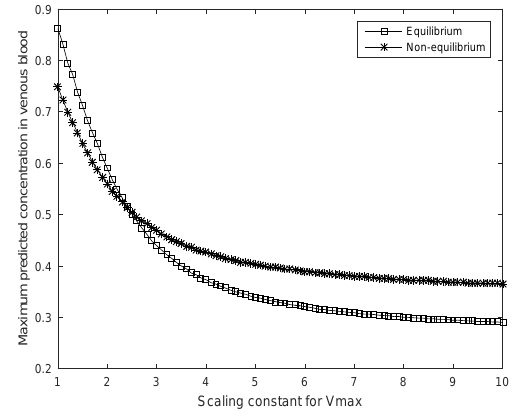
Fig. 5. Estimated area below the predicted liver concentration curve for various V xyl maxc